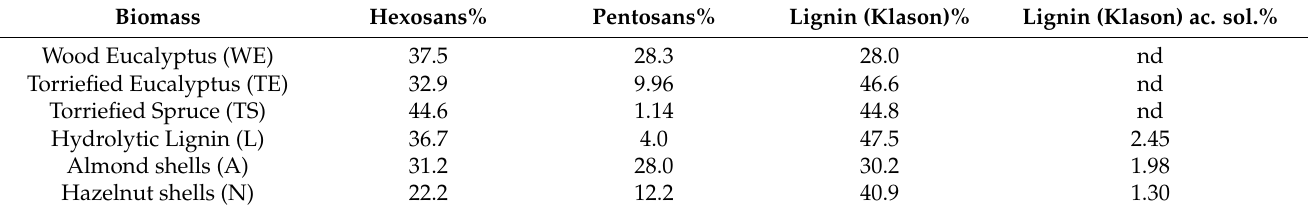
Table 2. Biochemical composition of the feedstocks (% dry weight) [19,21,22].